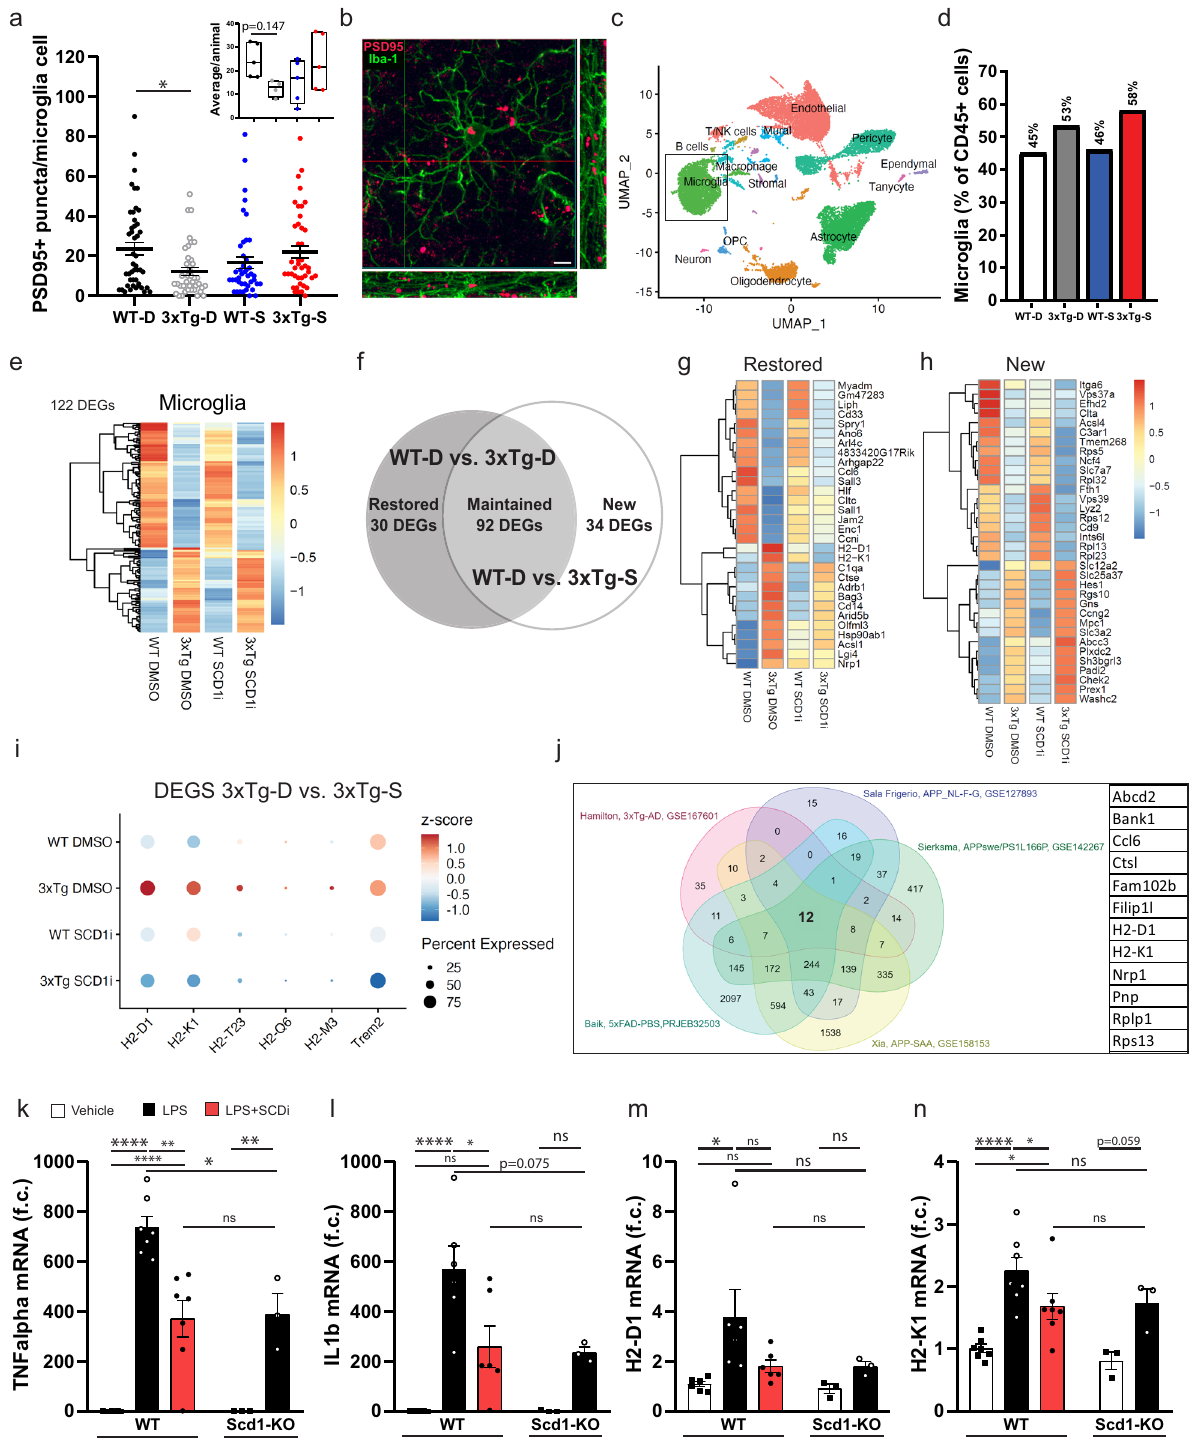
performance in aged canines 44 . Here, when we performed RNA sequencing on the whole 3xTg hippocampus, unbiased GO enrichment analysis speci fi cally highlighted fatty acid desaturase activity as a main dysregulated molecular function. The to be pleiotropic, as the cellular functions of lipids as